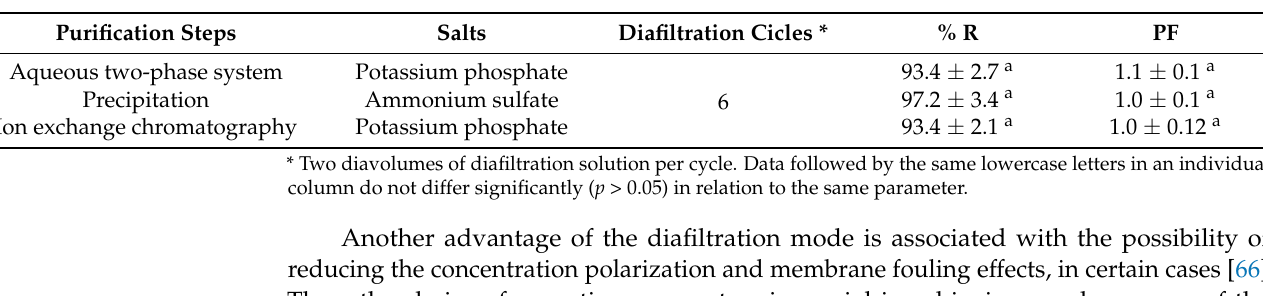
Table 3. Purification factor and β -galactosidase recovery in the diafiltration process after different